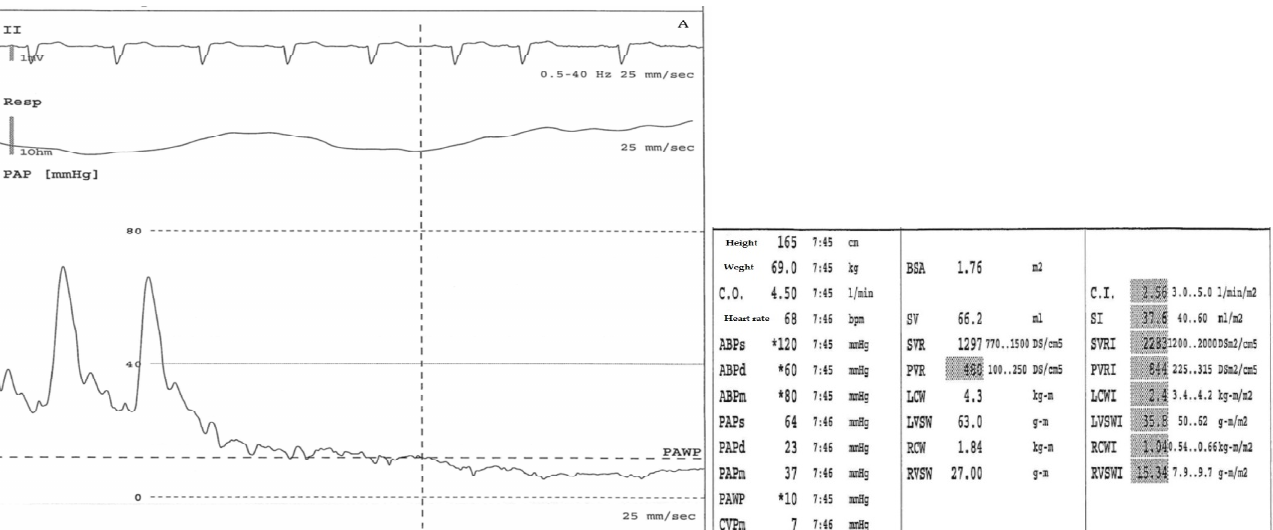
Figure 1. ( A ) Axial images from a pulmonary angio-CT demonstrating the presence of bands within the vascular lumen (arrow) and ( B ) a focal vascular stenosis secondary to an eccentrically located thrombus (arrow), due to incomplete thrombus resolution. ( C ) HRTC showing a diffuse mosaic pattern of perfusion (*), a typical radiological finding in chronic pulmonary thromboembolism. A correct differential diagnosis between CTEPH and IPAH is essential to make a therapeutic decision, as CTEPH can potentially be resolved by endarterectomy. Care is to be taken to distinguish CTEPH from other pathologies that can mimic the radiological picture of CTEPH, i.e., pulmonary artery sarcoma, tumor cell embolism, mediastinal fibrosis,